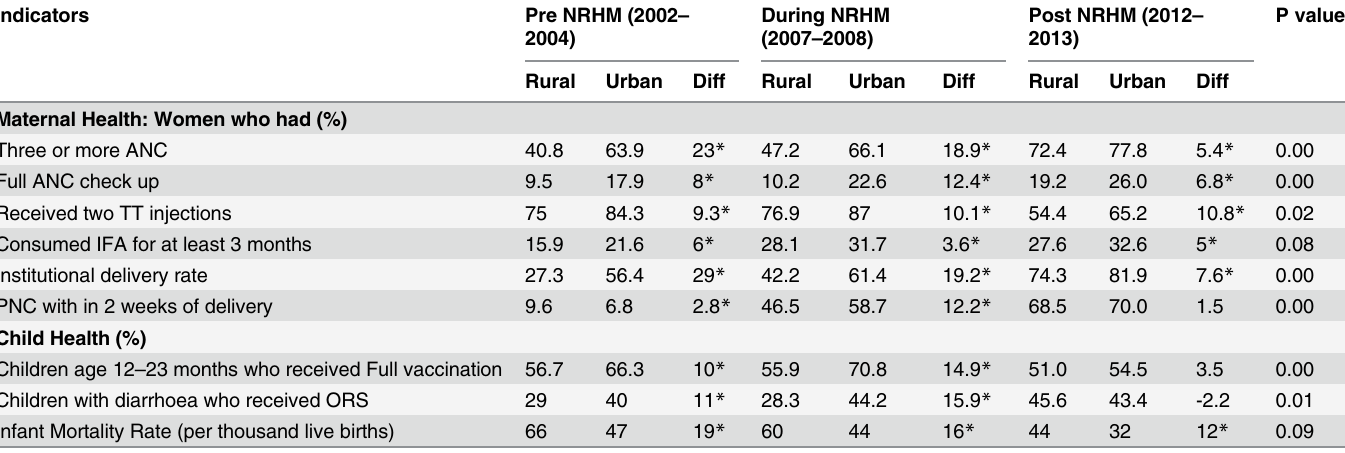
Table 1. Geographical inequalities in maternal and child health indicators in rural and urban area during pre, during and post NRHM implementa- tion (expressed as absolute difference in proportion of indicators in urban and rural area).